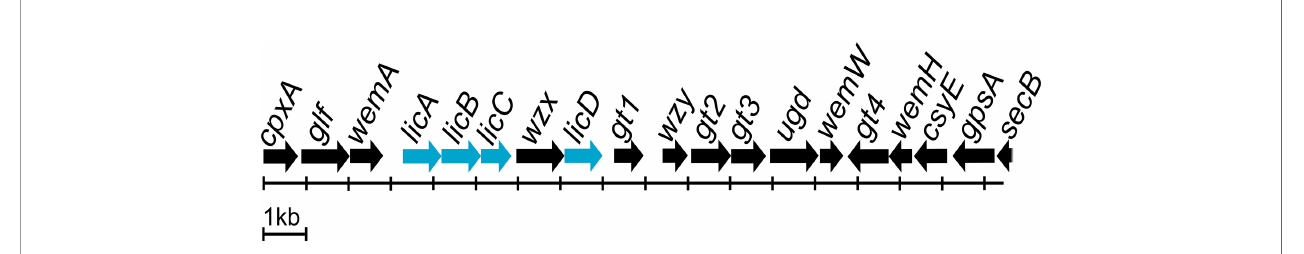
FIGURE 4 | Proteus mirabilis O18 O antigen gene cluster arrangement. Highlighted genes represent licABCD genes and its organisation in the Wzx/Wzy-dependent O antigen biosynthesis gene cluster. Scheme modi fi ed from Yu et